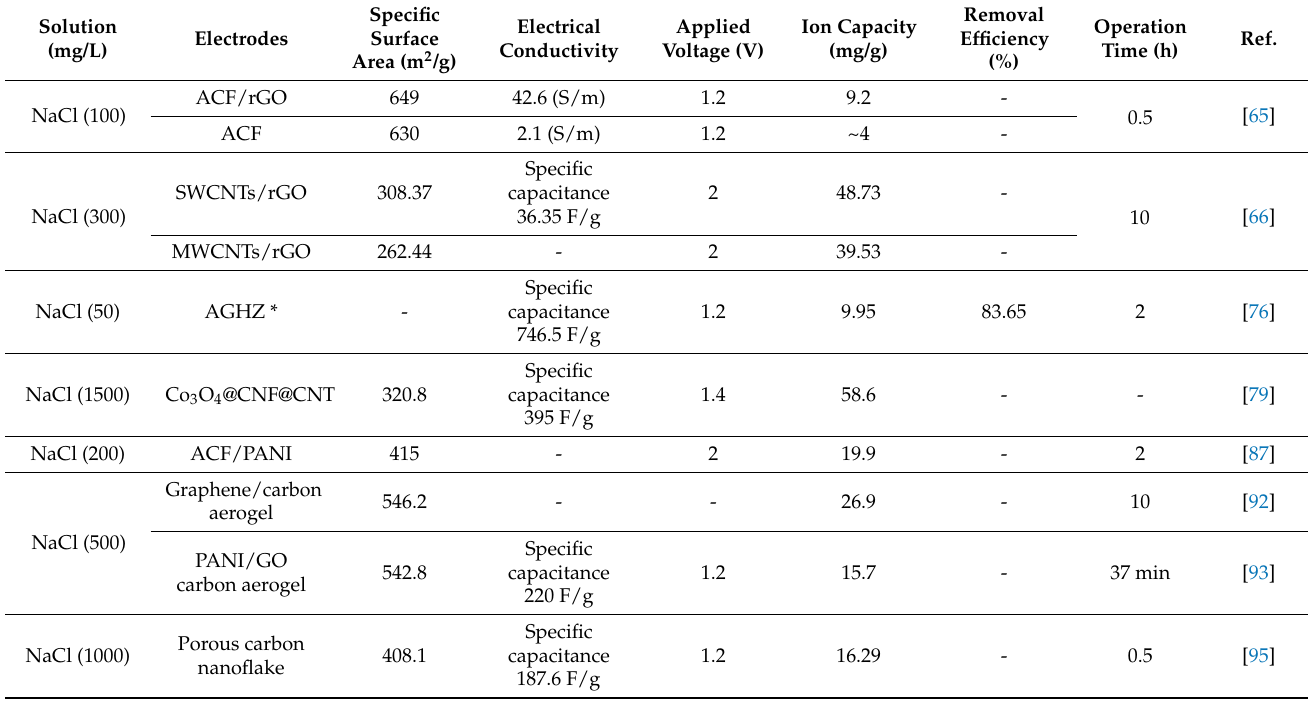
Table 1. CDI performances of various carbon-based electrode